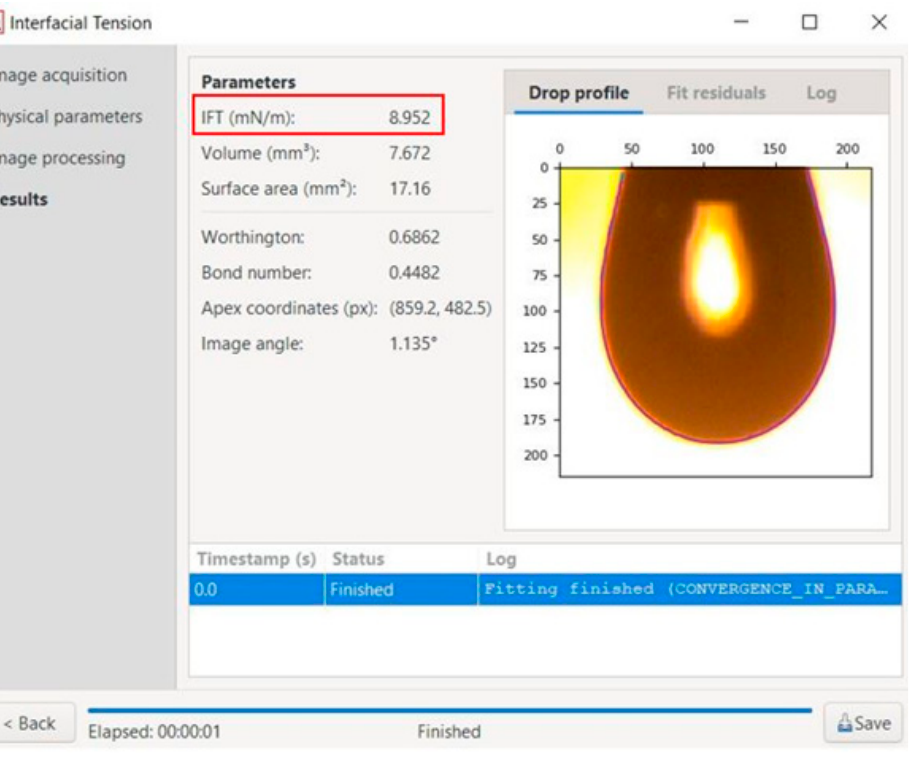
Figure 3. The interface of the drop region in the OpenDrop (Melbourne, Victoria) program.